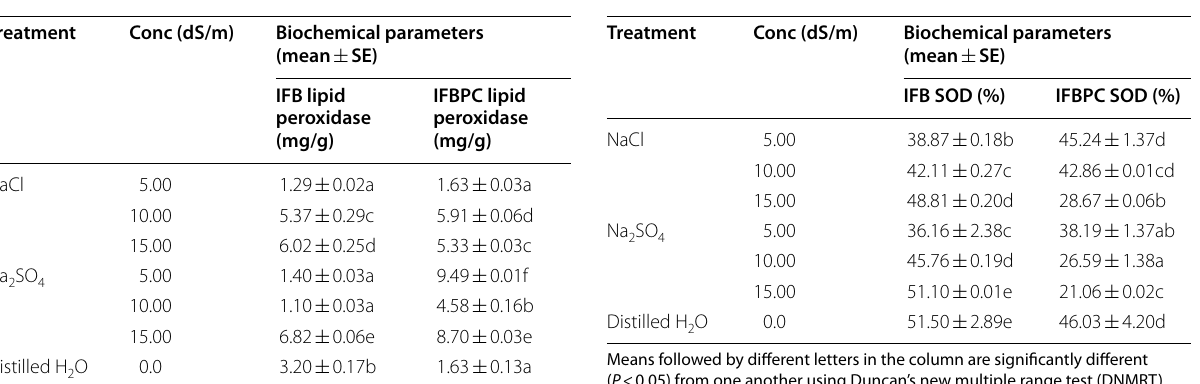
SO salinity 2 4